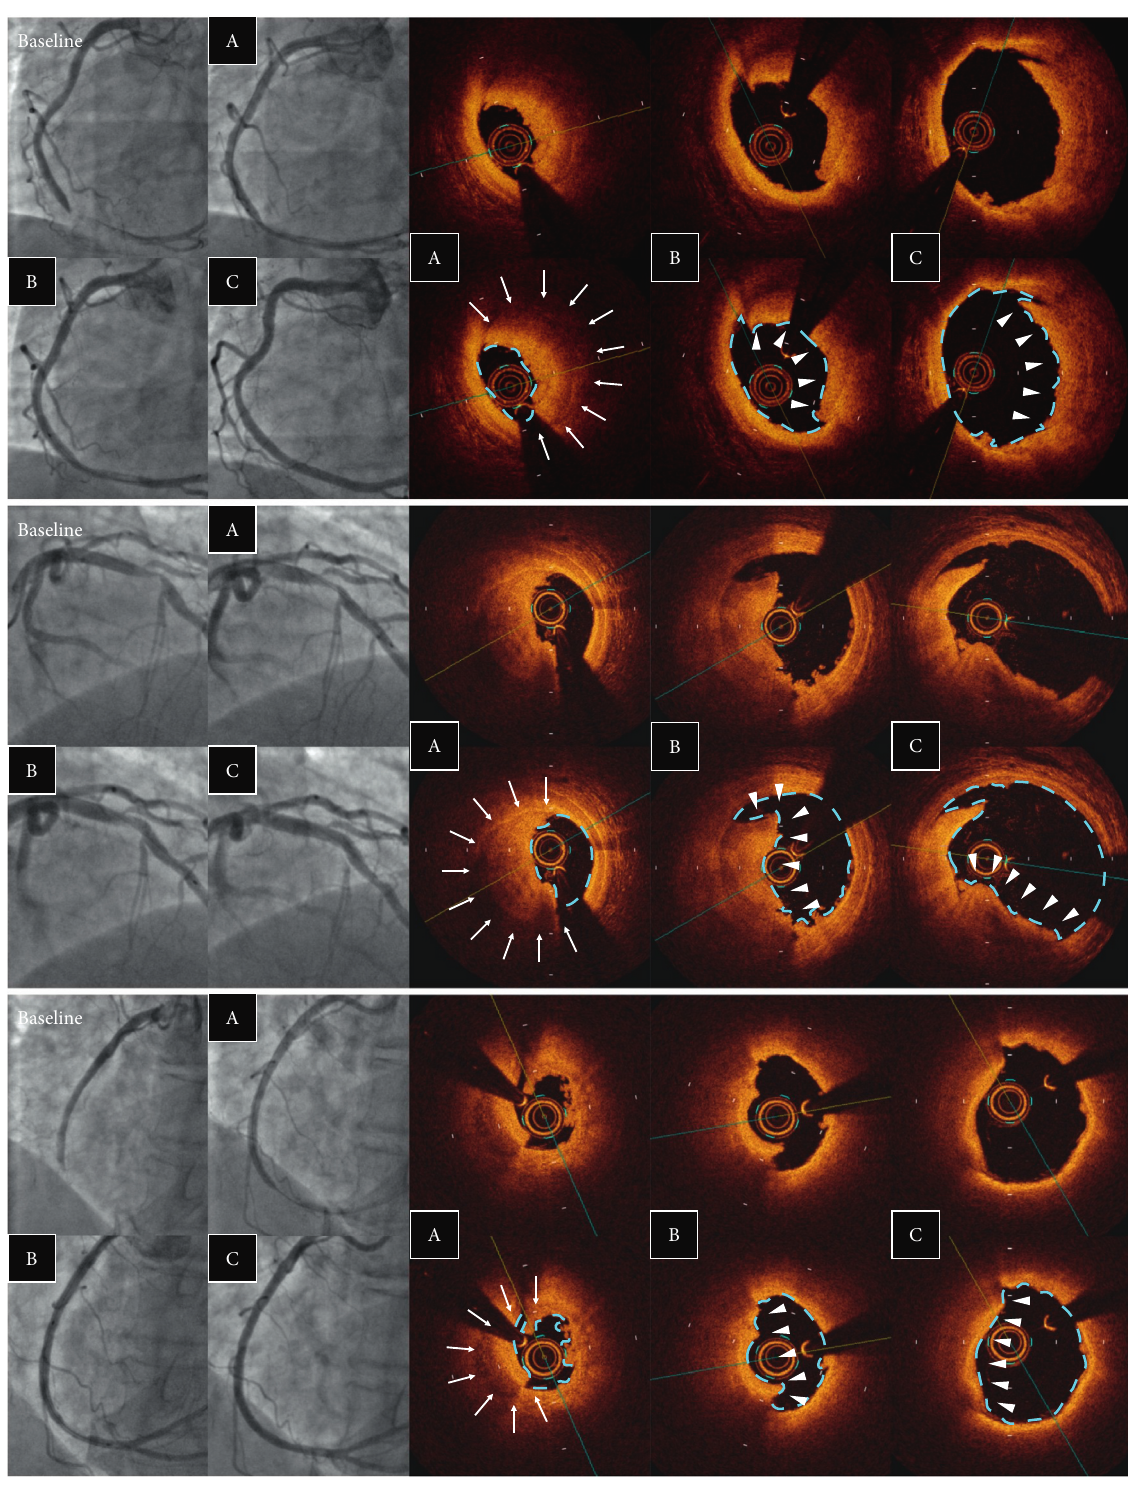
Figure 5: Examples of plaque erosion. Angiographic and OCTimages after (A) MT, (B) ELCA, and (C) ballooning. Laser vaporization of the thrombus (arrow) clarified the identification of the attached thrombus overlying the eroded plaque (arrow head). ELCA, excimer laser coronary angioplasty; MT, manual aspiration thrombectomy; and OCT, optical coherence